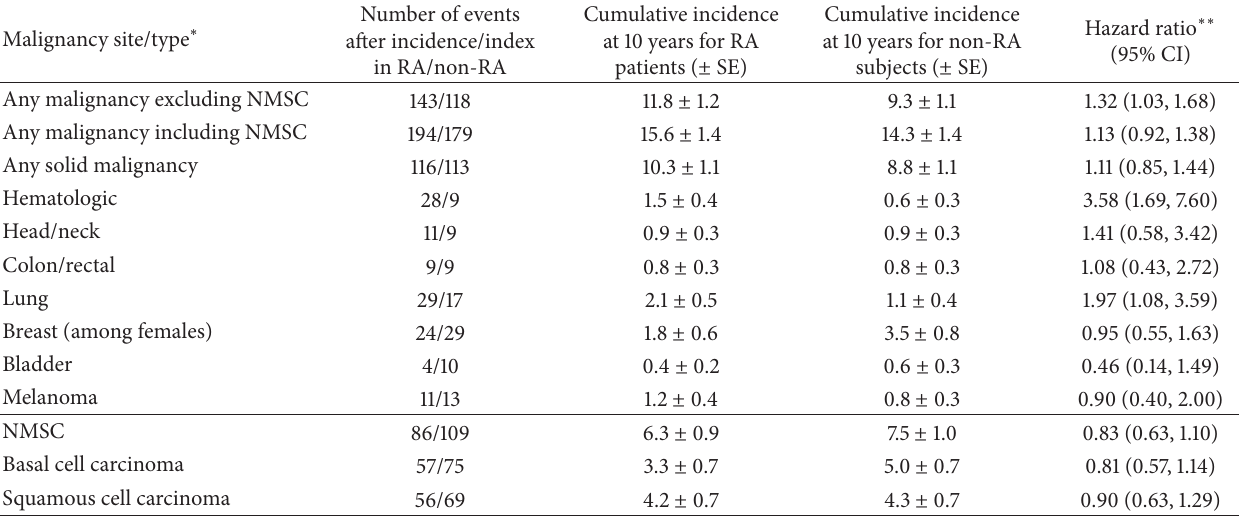
Table 1: Cumulative incidence rates of malignancy in 813 patients with rheumatoid arthritis in 1980–2007 compared to 813 subjects without rheumatoid